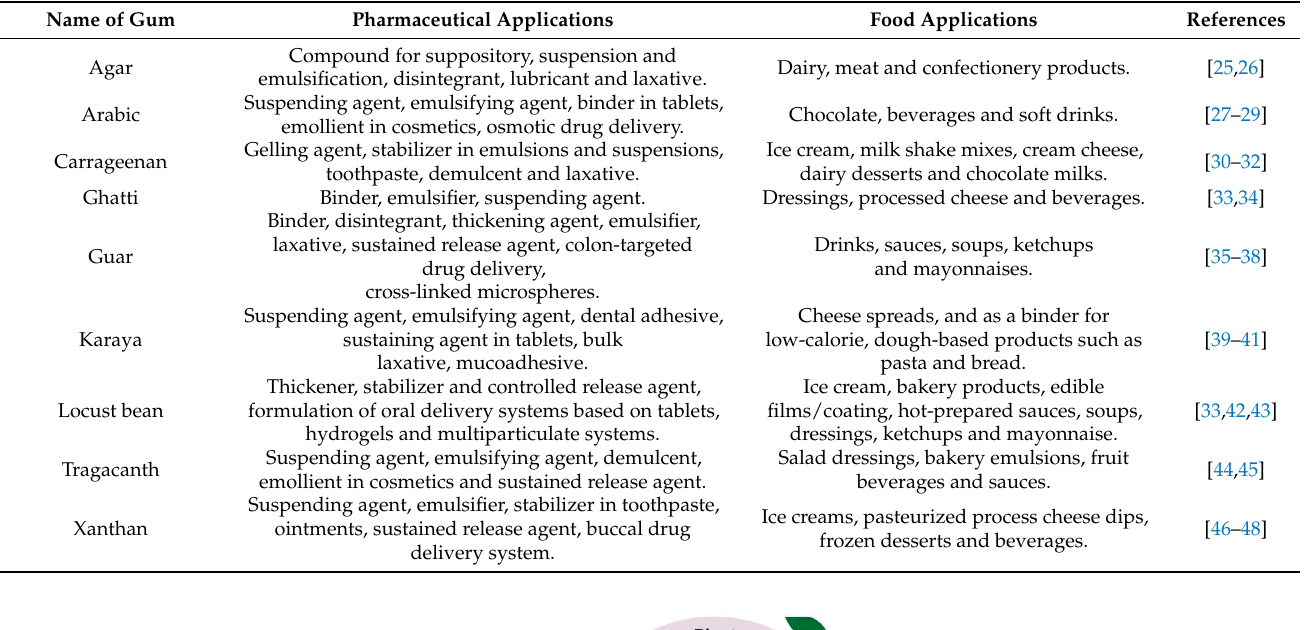
Table 1. Pharmaceutical and food applications of the main gums on the market.